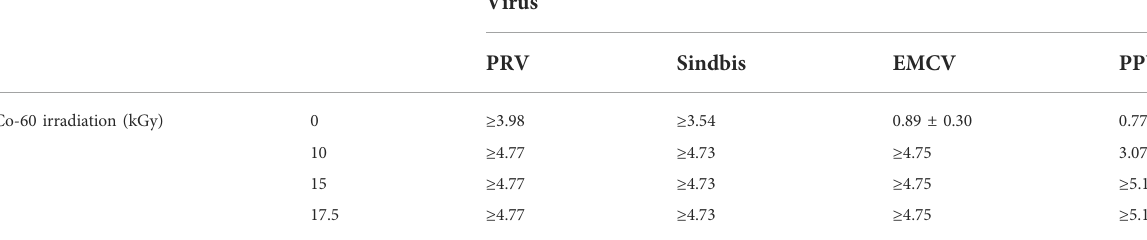
Data represent mean ± SD, and n = 3 biological